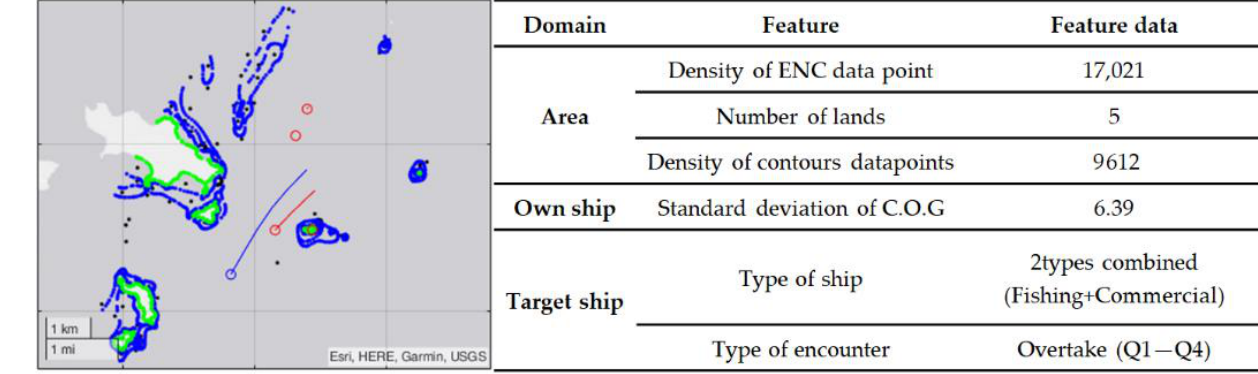
Figure 8. Features in sample